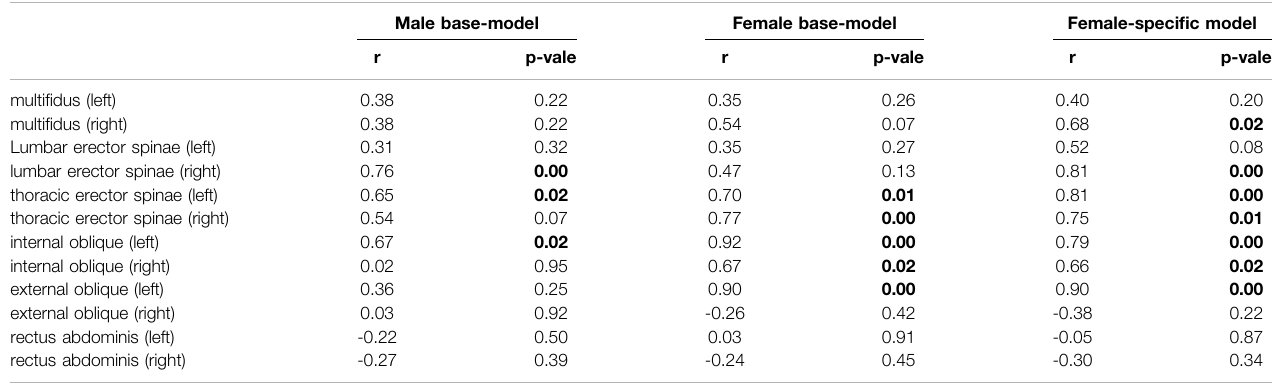
TABLE 4| Pearsoncorrelations betweenmuscleactivities predicted bymodelsandEMGsignalsrecordedfromparticipants ’ musclesduringliftingtasks.Thebolded values indicate a linear relationship between measured and predicted muscle activity ( p <